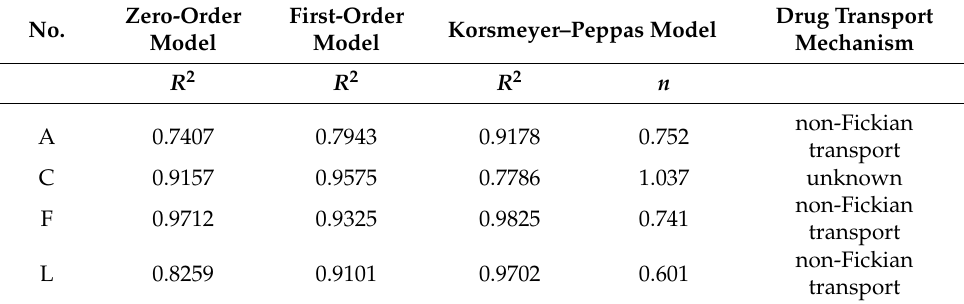
Table 6. Analysis data of 5-FU release from